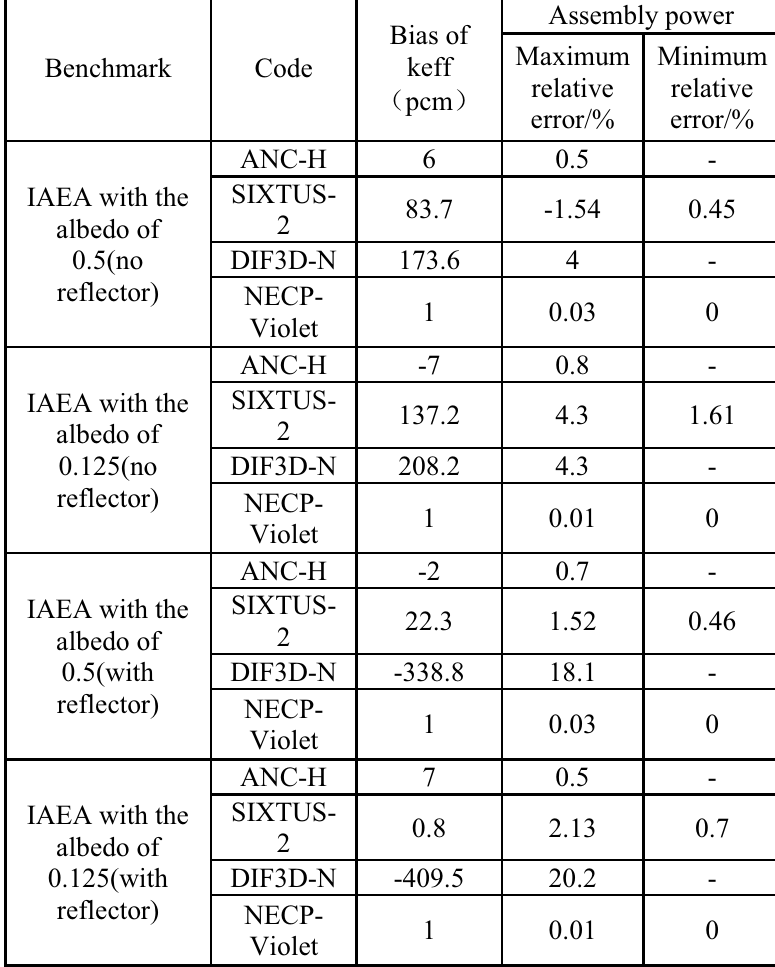
Table I. Results of some diffusion